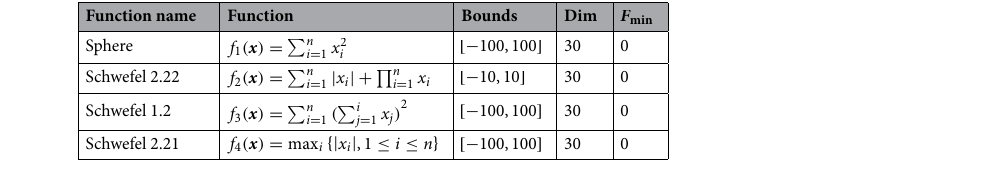
Table 1. Unimodal benchmark functions.